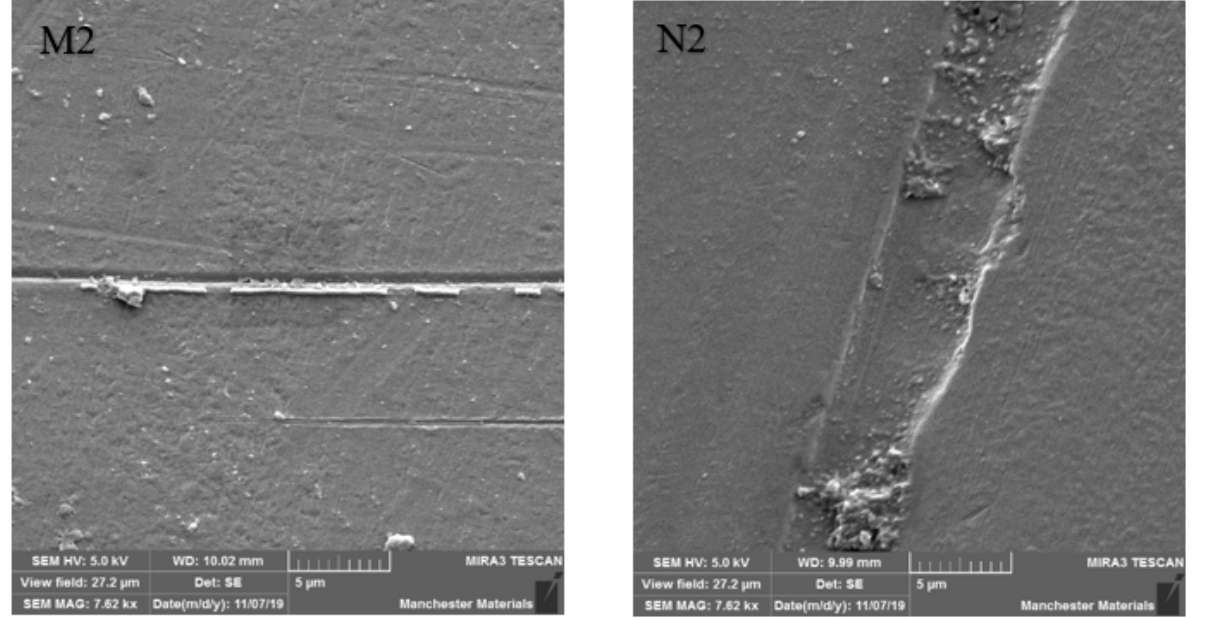
Figure 7. SEM imaging at 7.62 kx magnification at the point of impact. Note that the width of destruction and amount of particle debris are larger in N2 compared to M2.